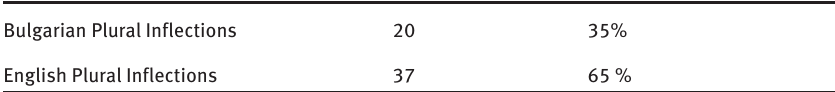
Table 3. Plural inflections of English nouns – number and percentage